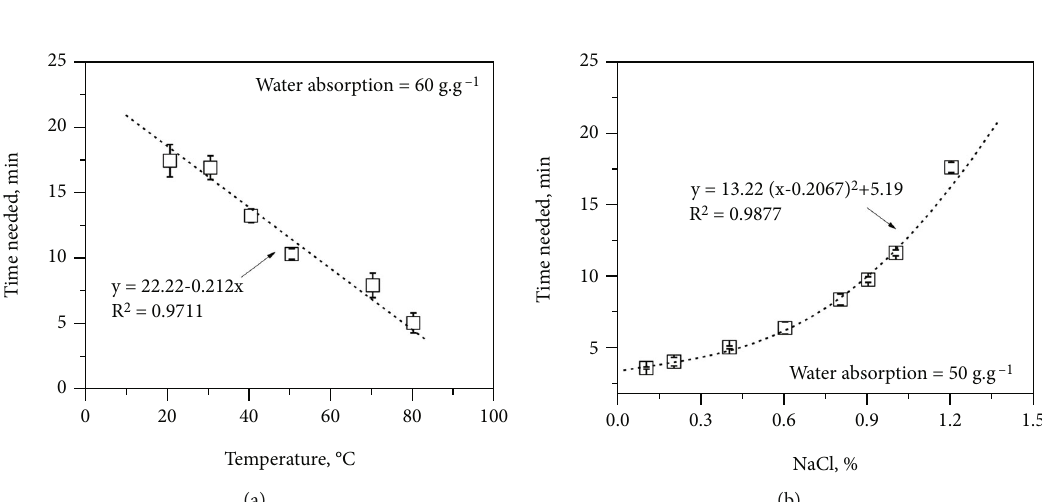
Figure 6: E ff ect of (a) temperature and (b) NaCl on the swelling time needed at the given